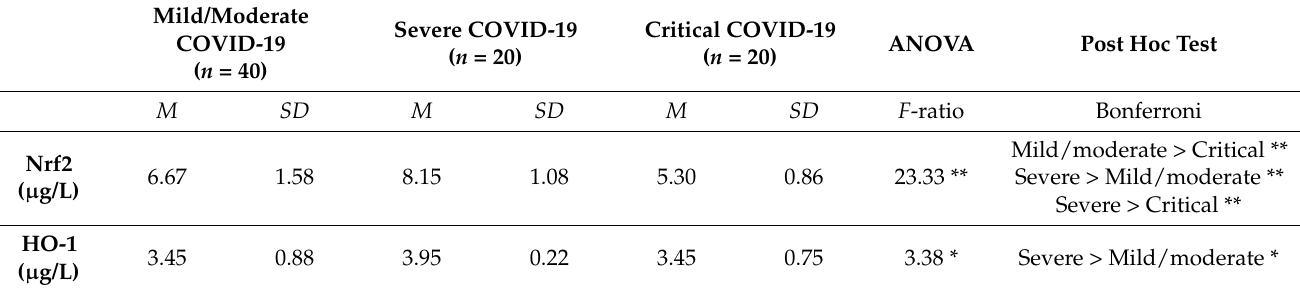
Table 2. Correlation of concentration of Nrf2 and HO-1 with severity of the